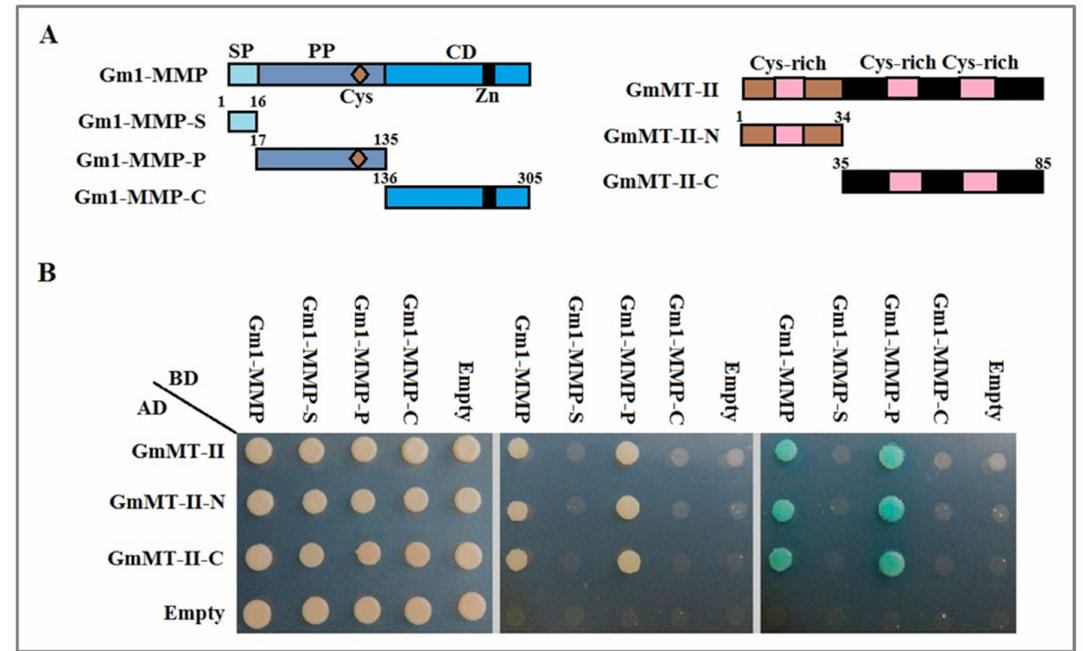
Figure 4. Screening of Gm1-MMP and GmMT-II interaction sites in Yeast. ( A ) Binding site prediction. ( B ) Different binding sites point to point